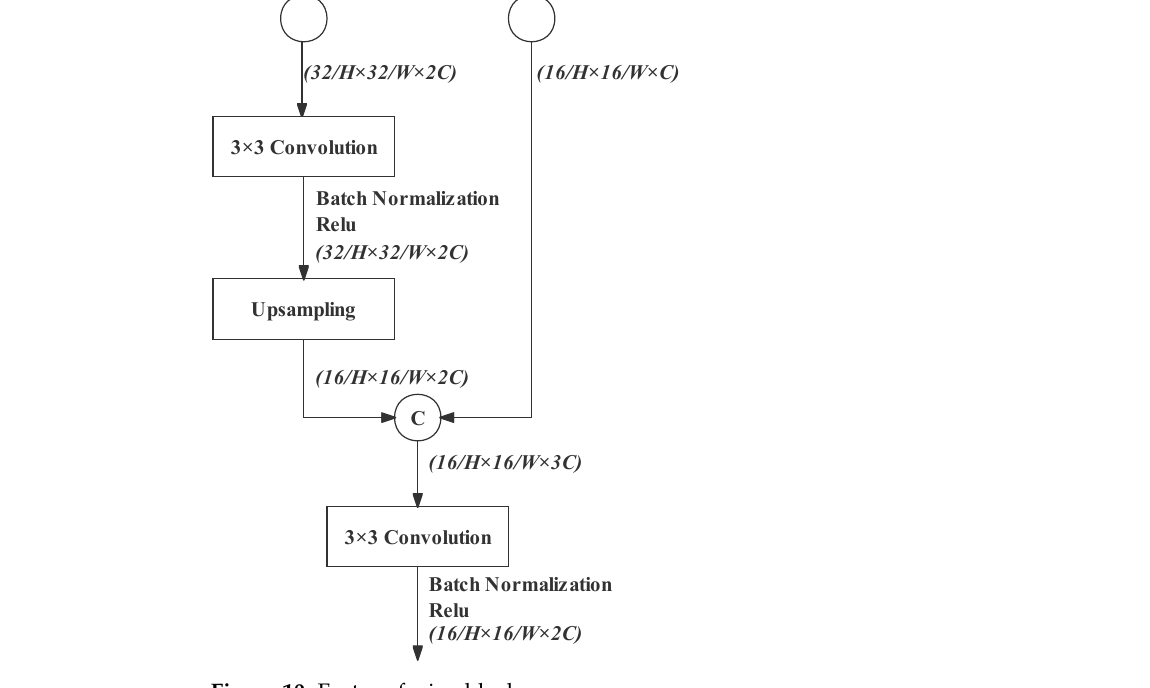
Figure 10. Feature fusion block.